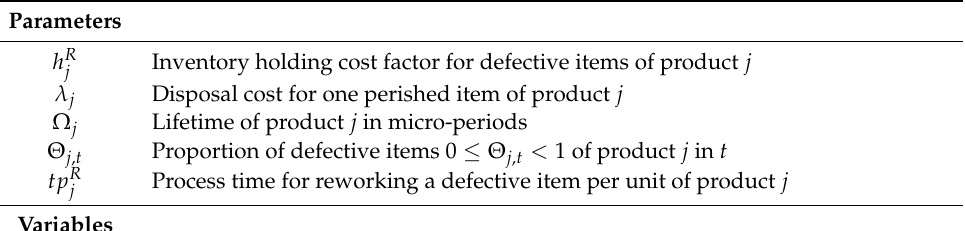
Table 2. Additional variables and parameters for the general lot sizing and scheduling problem with defective items and lifetime constraints